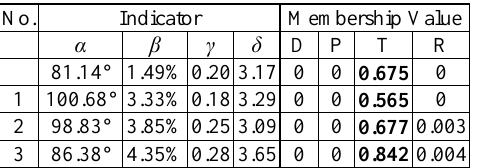
Table 5 Assessment result of trellis case